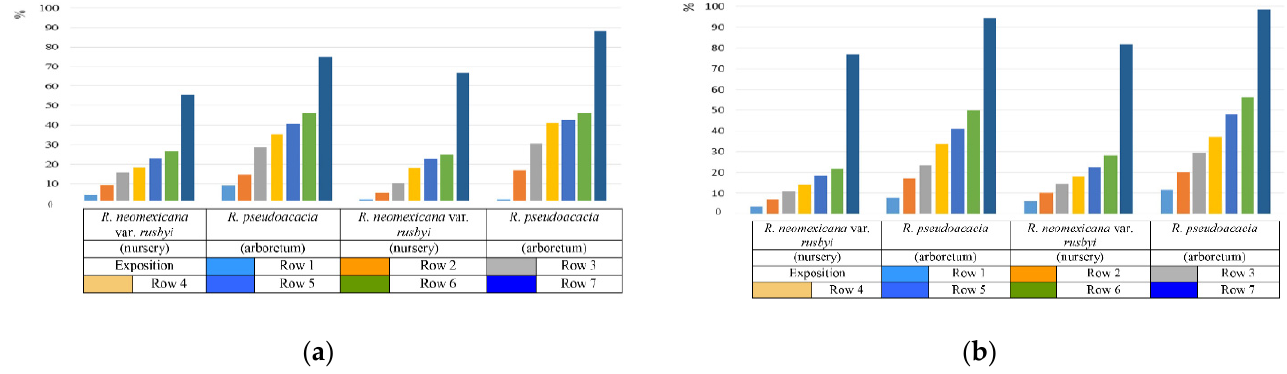
Figure 5. Water–holding capacity of leaf tissues (( a )—July, ( b )—September, on average 2019–2021) of R. pseudoacacia and R. neomexicana var. rusbyi under various cultivation conditions, expressed in % ratio of lost water to the original content.